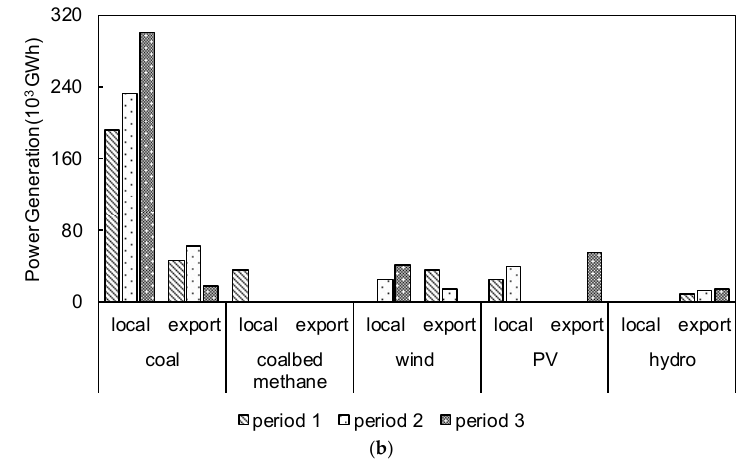
Figure 8. Comparison of power generations from FCFP and Least-system-cost models. ( a ) FCFP model; and ( b ) least-system-cost model.